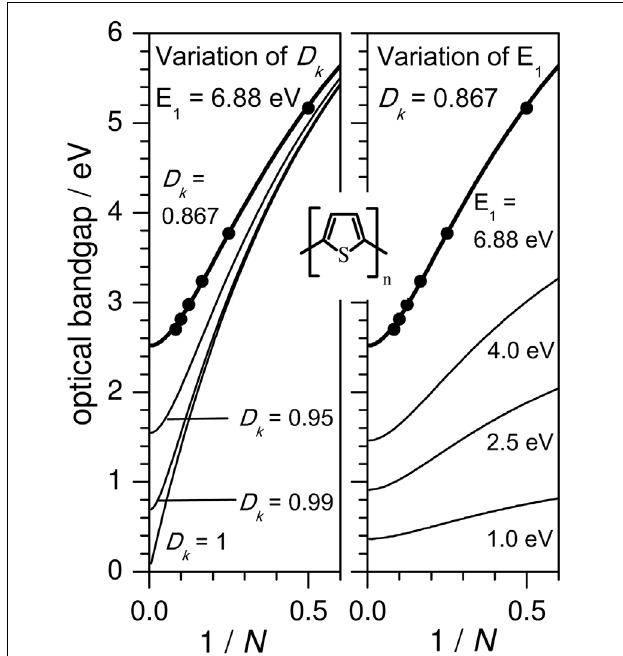
FIGURE 1 | Optical bandgaps as a function of 1/ N with N as the number of double bonds on the shortest conjugation pathway between the terminal carbons. Solid circles: Experimental values ( in vacuo ) for oligothiophenes n T (where n = 2 N ) (Gierschner et al., 2007). Solid line: Fit according to the Kuhn equation ( Figure 2 ) with E 1 = 6 . 88, D k = 0 . 867. Variation of the Kuhn parameters D k (left) and E 1 (right).